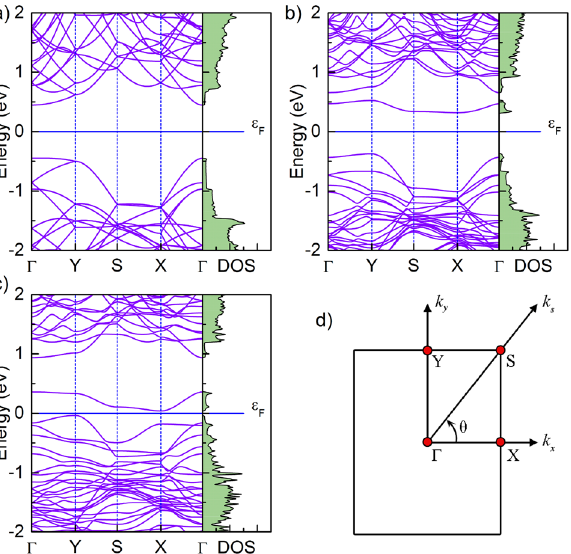
Figure 4. Electronic band structure along the Ŵ –Y–S–X– Ŵ direction and density of states (DOS) of ( a ) pristine, ( b ) B-doped, and ( c ) Cu-doped phosphorenes. The Fermi level set to zero is marked with the horizontal blue line. ( d ) The irreducible Brillouin zone of phosphorene with high-symmetry points marked by red